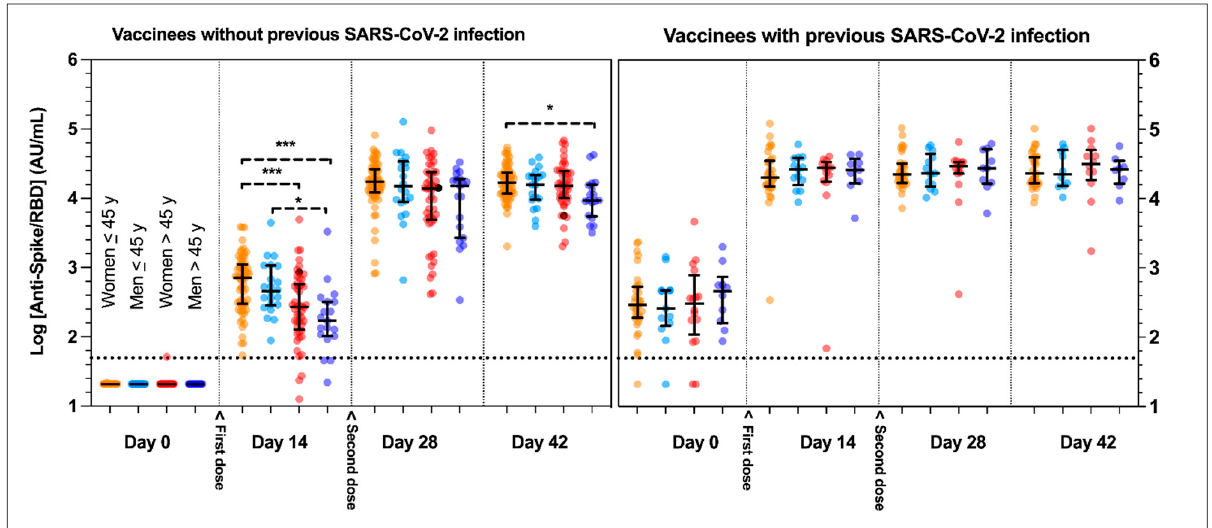
Figure 1. Kinetic response of anti-spike receptor-binding-domain protein (anti-Spike/RBD) antibodies in vaccinees without or with previous SARS-CoV-2 infection. Y-axes represent log 10 -transformed anti-Spike/RBD values. Horizontal dotted lines represent the positive threshold (= 50 AU/mL). The second dose was systematically administered at day 21. Groups were separated according to their previous coronavirus disease 2019 (COVID-19) status, sex and age ( ≤ or >45 years, a threshold chosen given the close median values observed in the two genders). Data are presented with median and interquartile range (IQR). *** p < 0.0001; * p < 0.05.